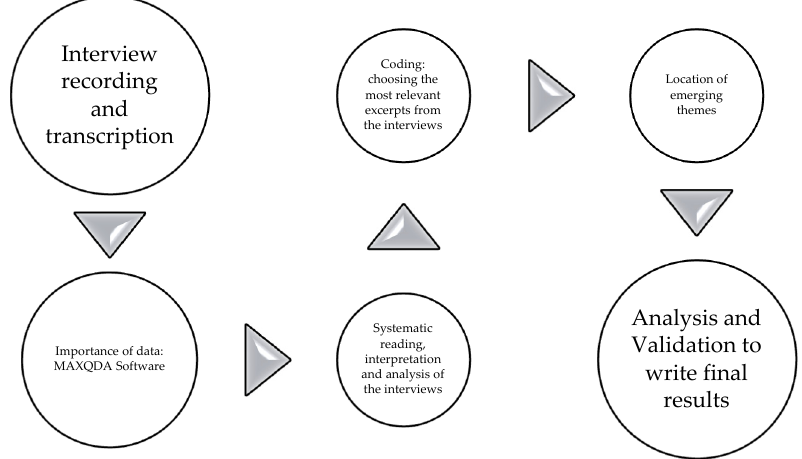
Figure 2. Description of the data analytical process. Source: adapted by Silva and Oliveira (2020) .